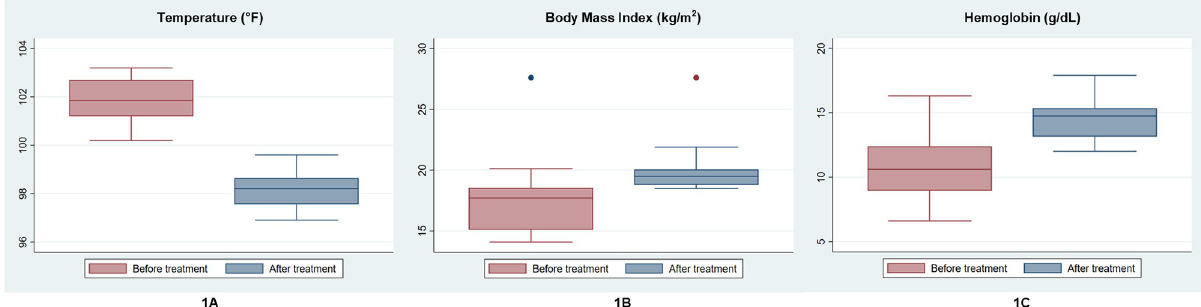
Fig 1. Before and one year after treatment, clinical characteristics of the Para-KDL patients. 1A - mean body temperature (˚F), 1B - mean BMI, and 1C - mean Haemoglobin level.